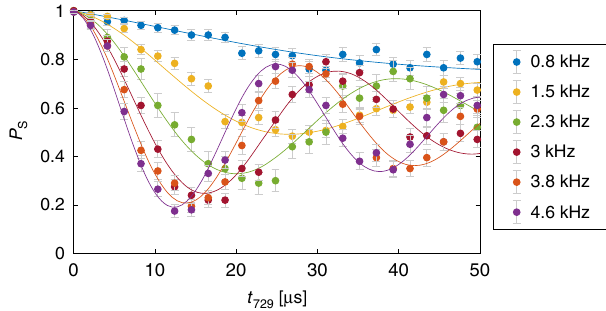
Fig. 7 Calibration measurements: Rabi-oscillation data from a two-ion Ca + – N 2 H + string. The Ca + ion is prepared in the (4 s ) 2 S 1/2 ( m = − 1/2) state with a well de fi ned ac-Stark shift. The contribution of N 2 H + to the excitation signal is corrected for iteratively (see text). The legend shows the second-iteration ac-Stark shift values including the contribution from N 2 H + . Error bars represent 1 σ binomial